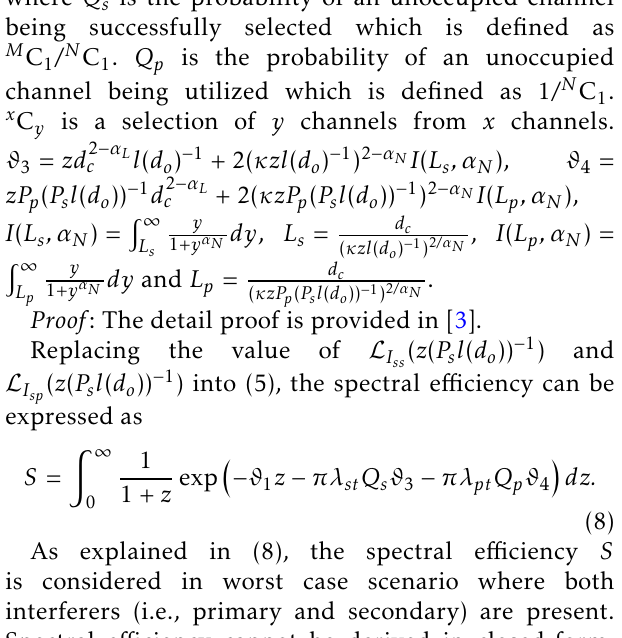
and ρ . It is assumed that s